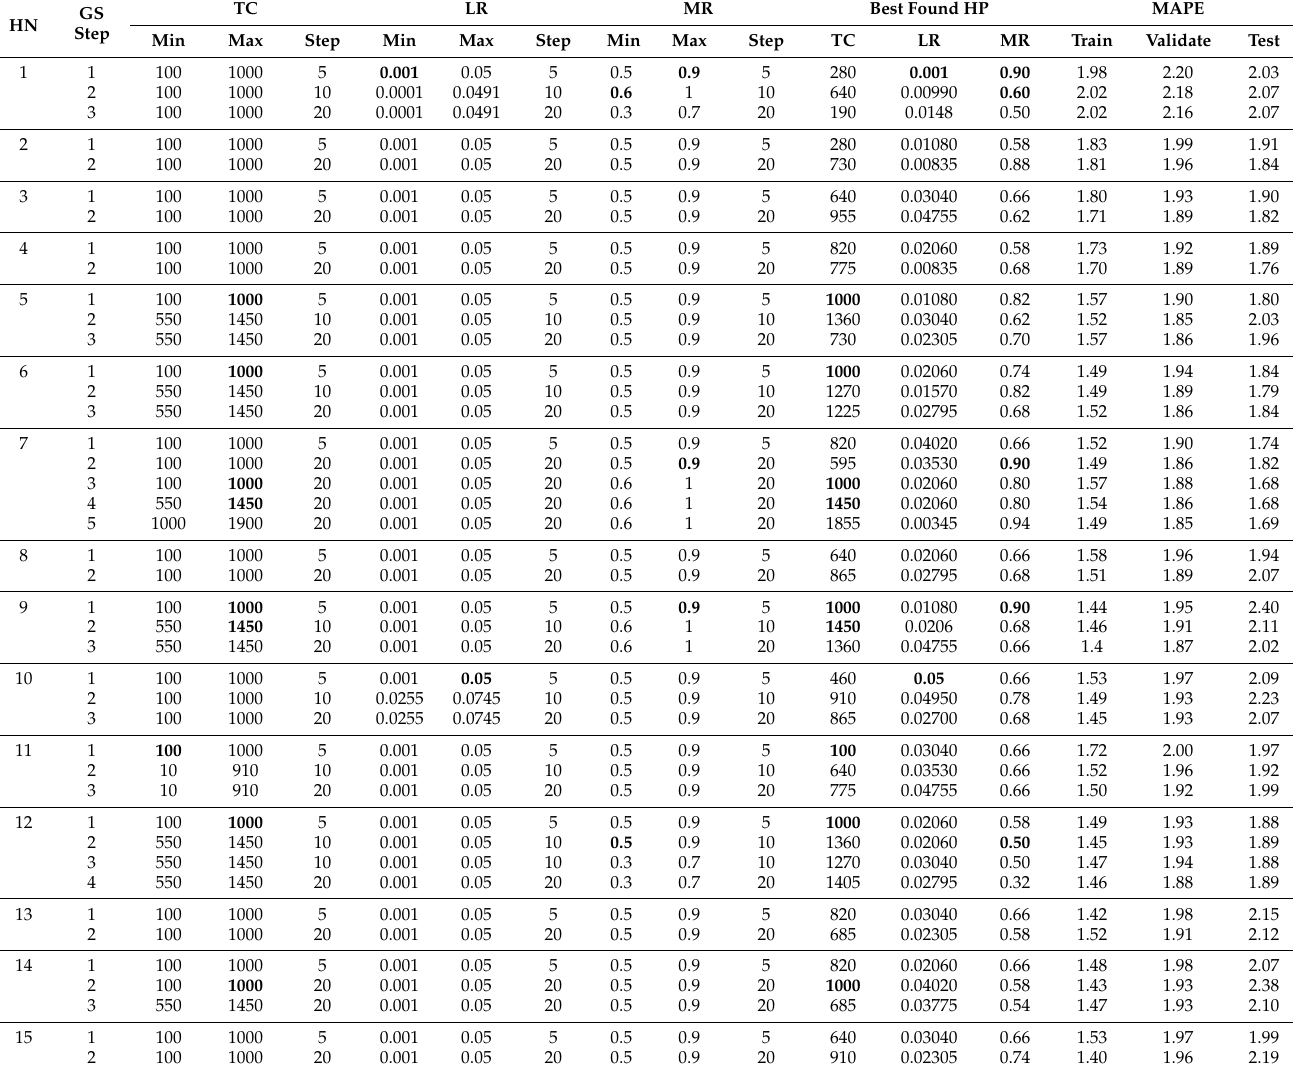
Table 5. Sequential grid search result of ANN (Hyperparameter values in bold indicate the values are on the search